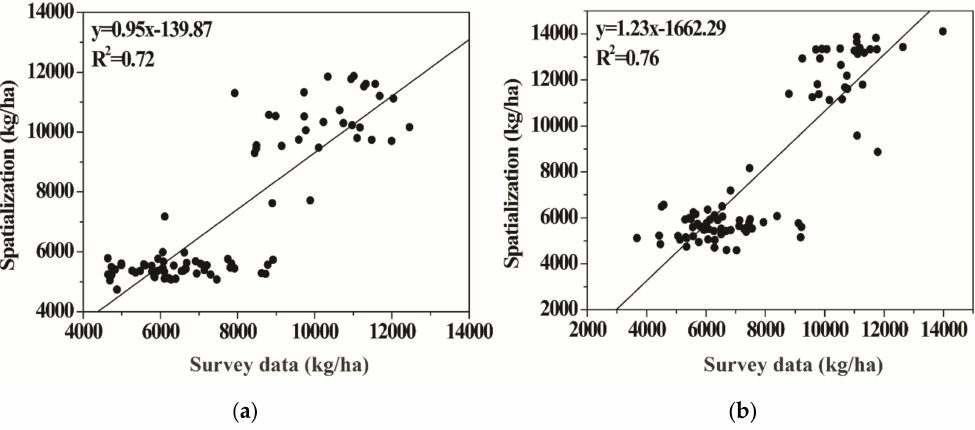
Figure 7. Regression analysis of per unit area yield in county level between spatialized results calculated by GCYS model and agricultural survey data of ( a ) per unit area yield of paddy rice in 2000; ( b ) per unit area yield of paddy rice in